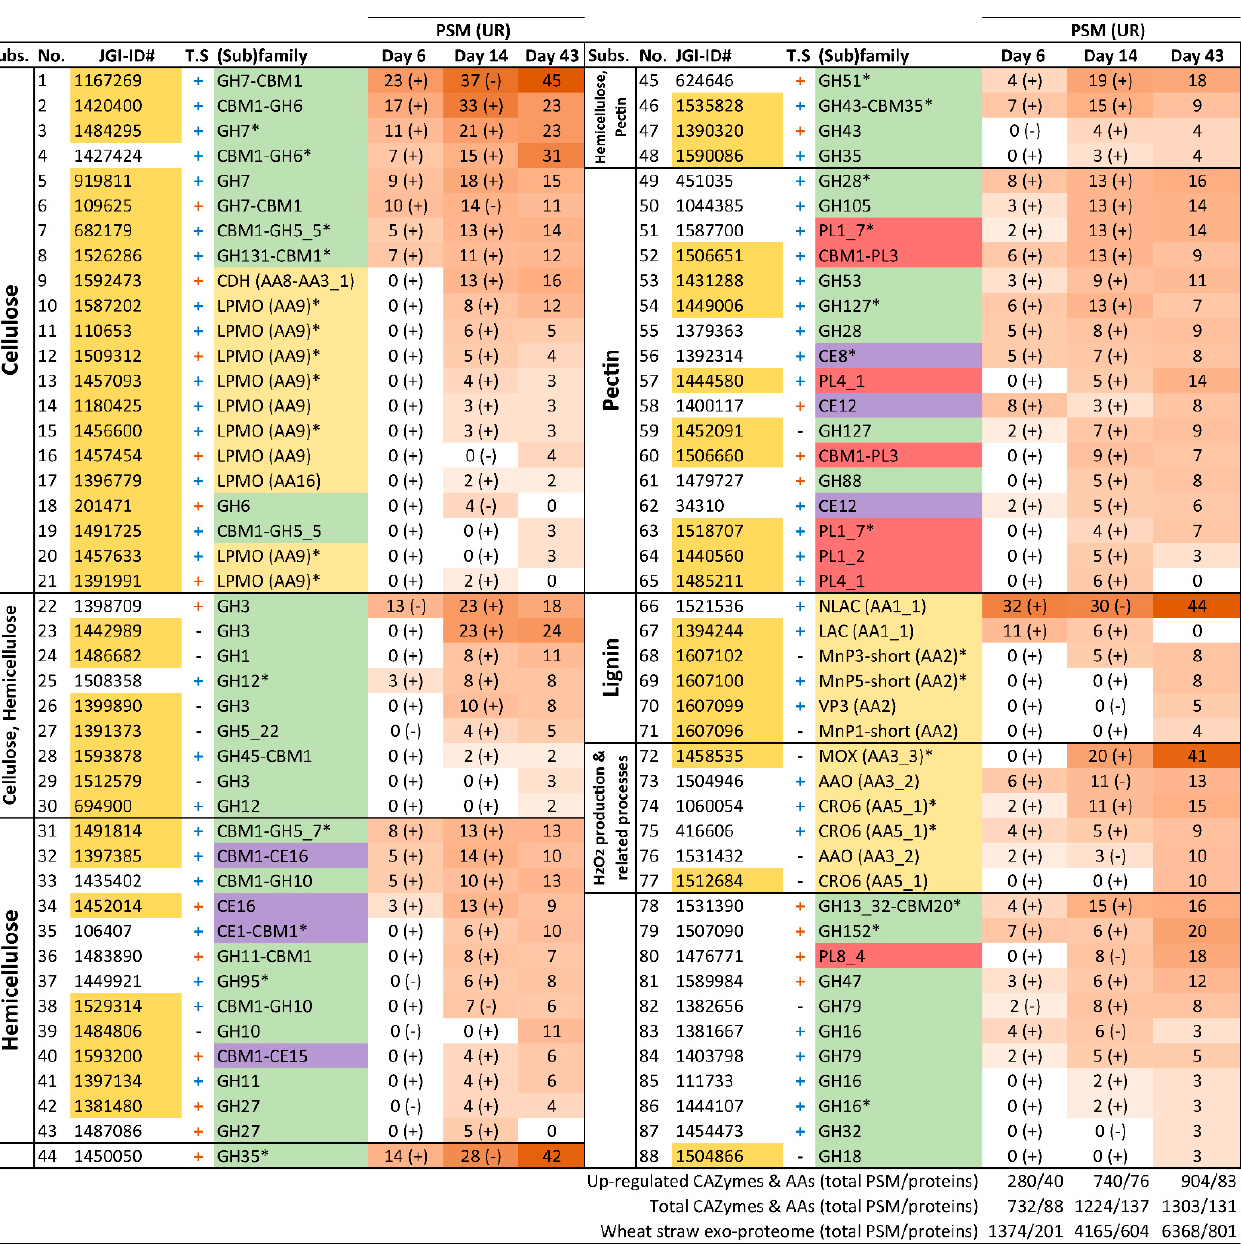
Figure 7. Up-regulated CAZymes and oxidoreductases (AA) identified in the wheat–straw exoproteome. The enzymes are organized according to the substrate on which they act or the process in which they participate (column “Subs”) and then sorted from highest to lowest abundance based on total PSM values. The protein reference numbers (JGI-ID#) correspond to those in the catalog of predicted proteins from the P. eryngii ATCC 90797 genome available through JGI MycoCosm Genome Portal. Protein references over yellow background are enzymes exclusively secreted on wheat–straw. The presence (+) or absence (-) of theoretical secretion (T.S) is indicated. Symbol + in blue or orange color represents proteins predicted to be secreted by the classical secretory pathway or by the unconventional pathway, respectively. Presence (+) or absence (-) of up-regulation (UR) in wheat–straw is indicated at day 6 and 14 following the PSM values. Enzymes 78–88 have not been related to lignocellulose degradation. * Proteins found both up-regulated and highly transcribed. Colors in the (sub)family column correspond to: GH, green; oxidoreductases, yellow; PL, red; and CE,